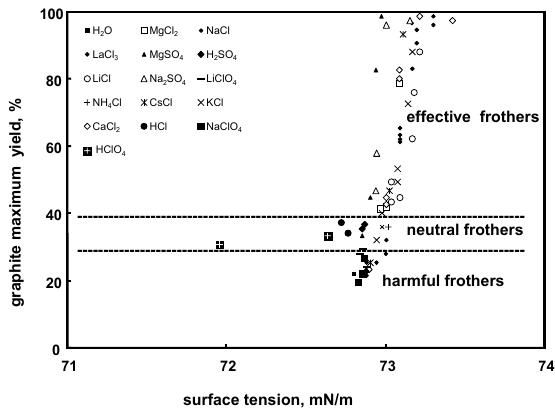
Figure 12. Influence of aqueous solution surface tension of inorganic salts and electrolytes on yield of graphite flotation (based on [62,65,66]).